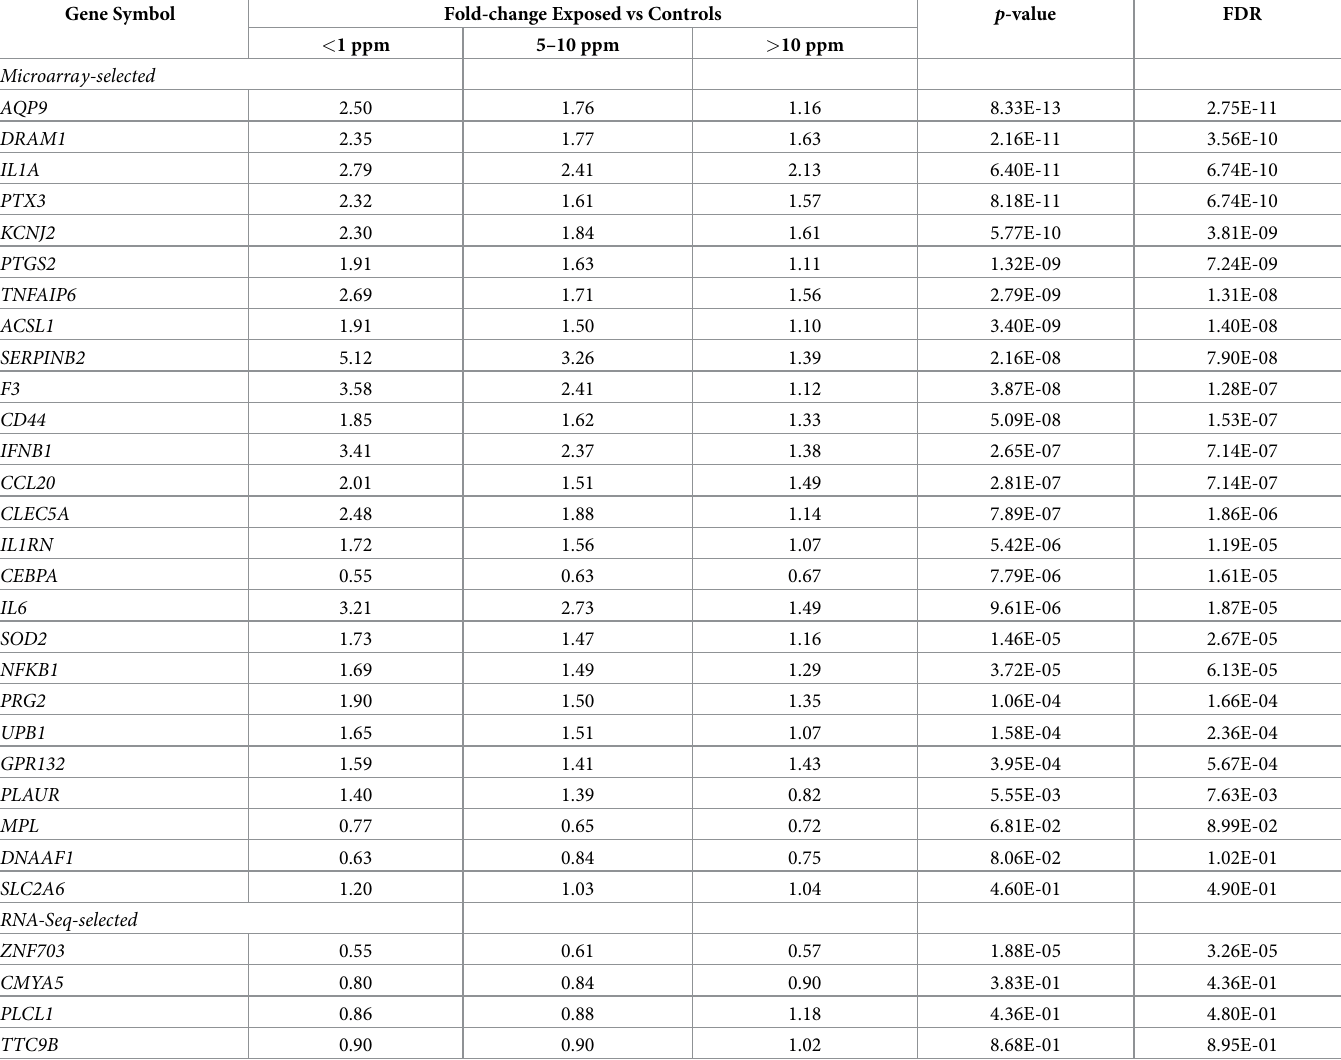
Table 4. Differential expression analysis of nCounter mRNAs in all 90